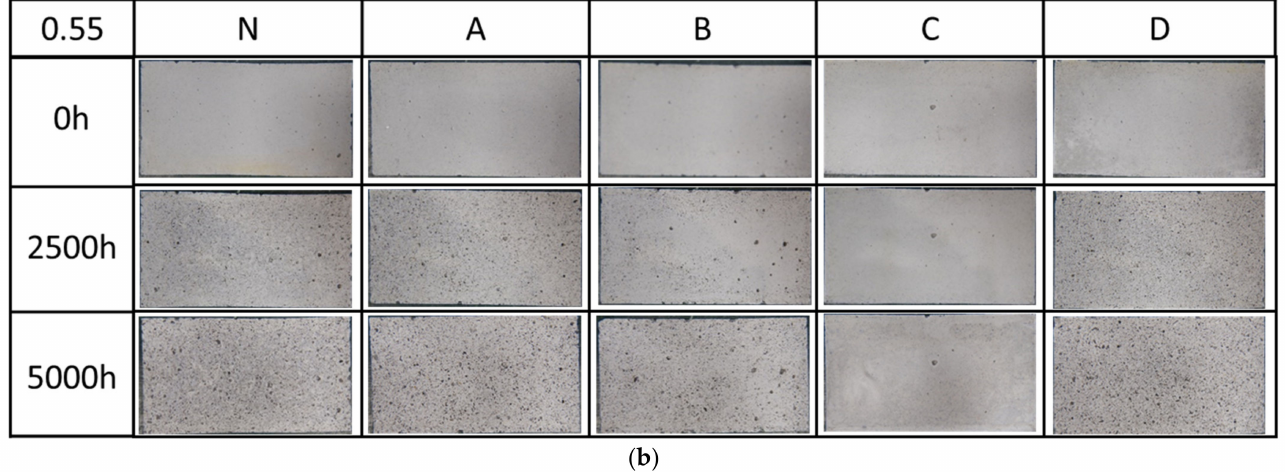
Figure 2. The Visual observation of the uncoated and coated specimens after 0 h, 2500 h and 5000 h weathering of w/c 0.45 ( a ) and 0.55 ( b ).